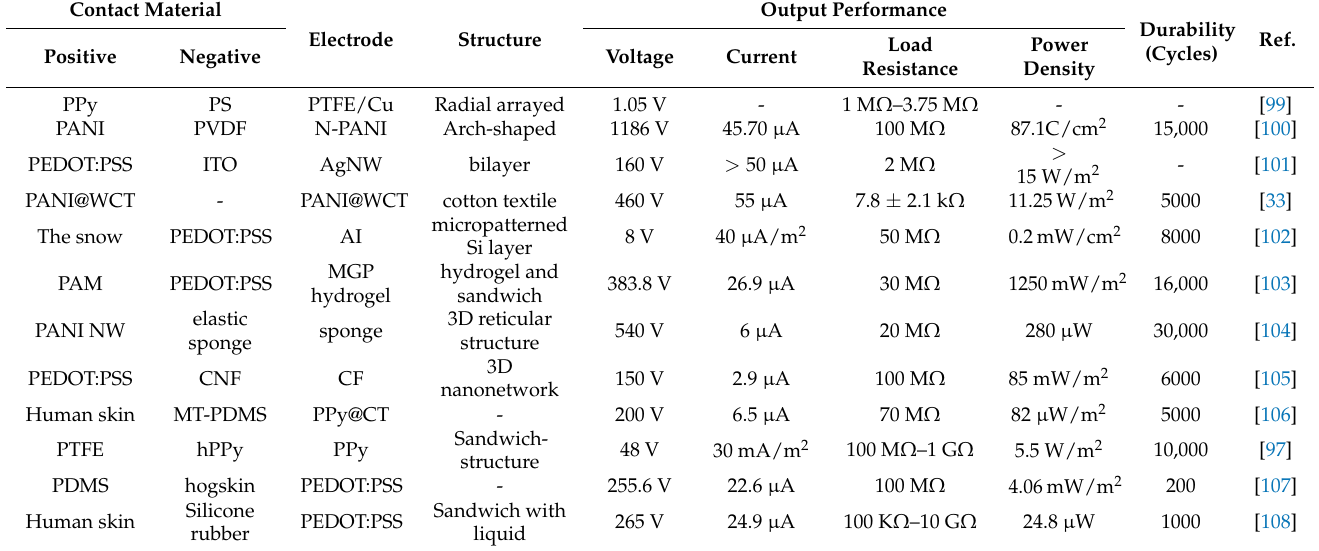
Table 2. Comparison of performance of selected conducting polymer-based TENG.